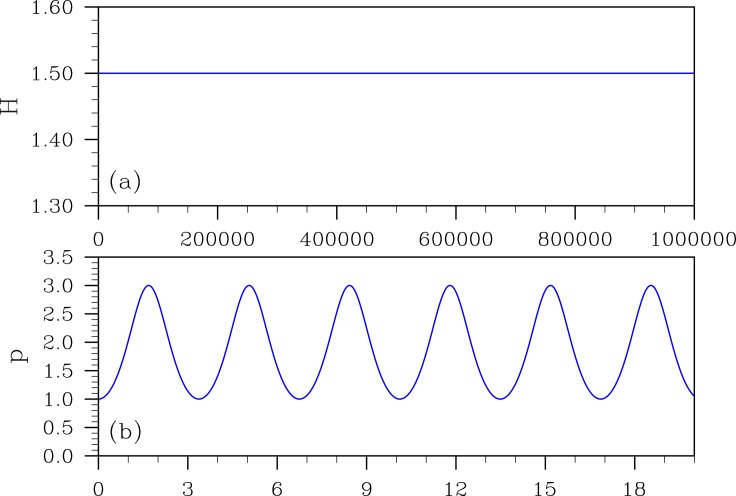
The direct simulation of Eq 5 by the 20-order PMT method, with a step-size of h = 0.01: (a) Hamiltonian H, (b) variable p versus time (the first 20 time units).